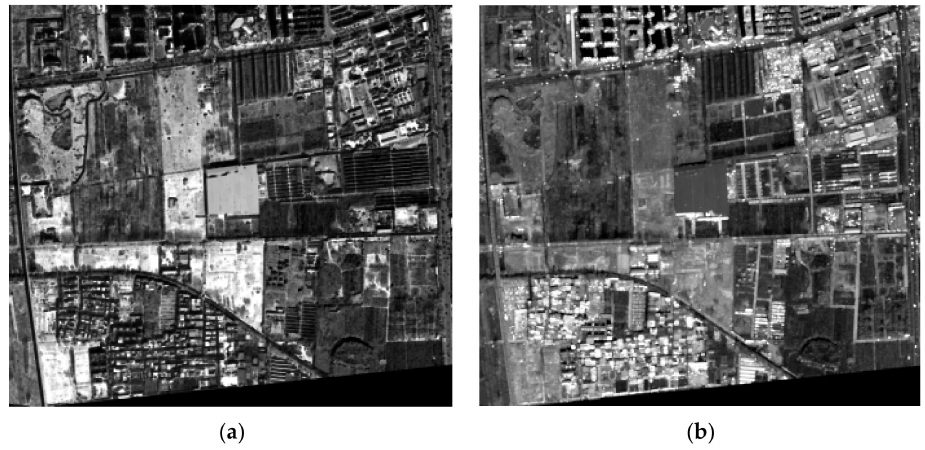
Figure 9. The results of the erosion ( a ) and dilation ( b ) operation on study area